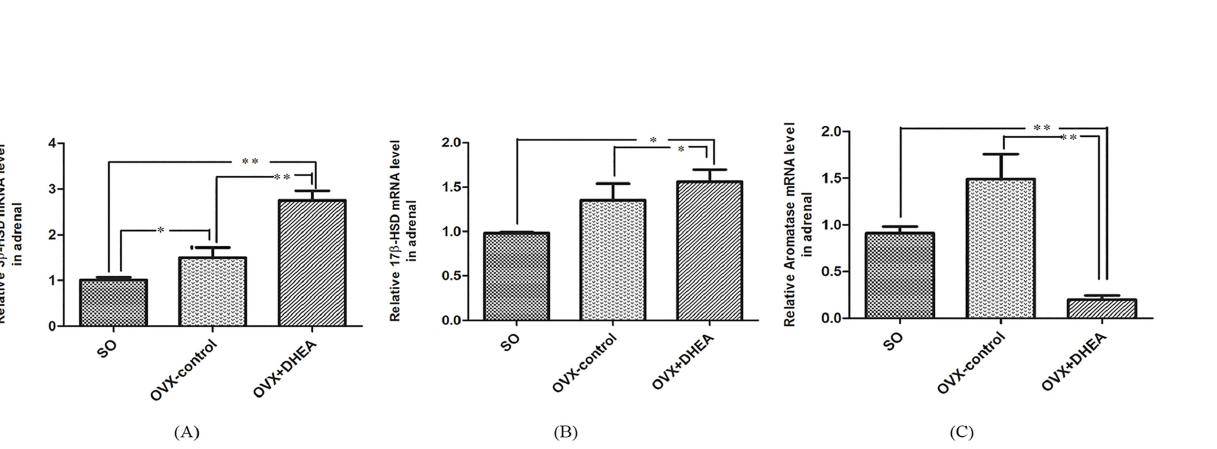
Fig 5. 3 β -HSD (A), 17 β -HSD (B) and aromatase (C) mRNA levels in adrenal in ovariectomised rats following DHEA administration for 6h. Data are expressed as means ± SE. ** P < 0 . 01 and * P < 0 . 05 , compared with the respective control group.